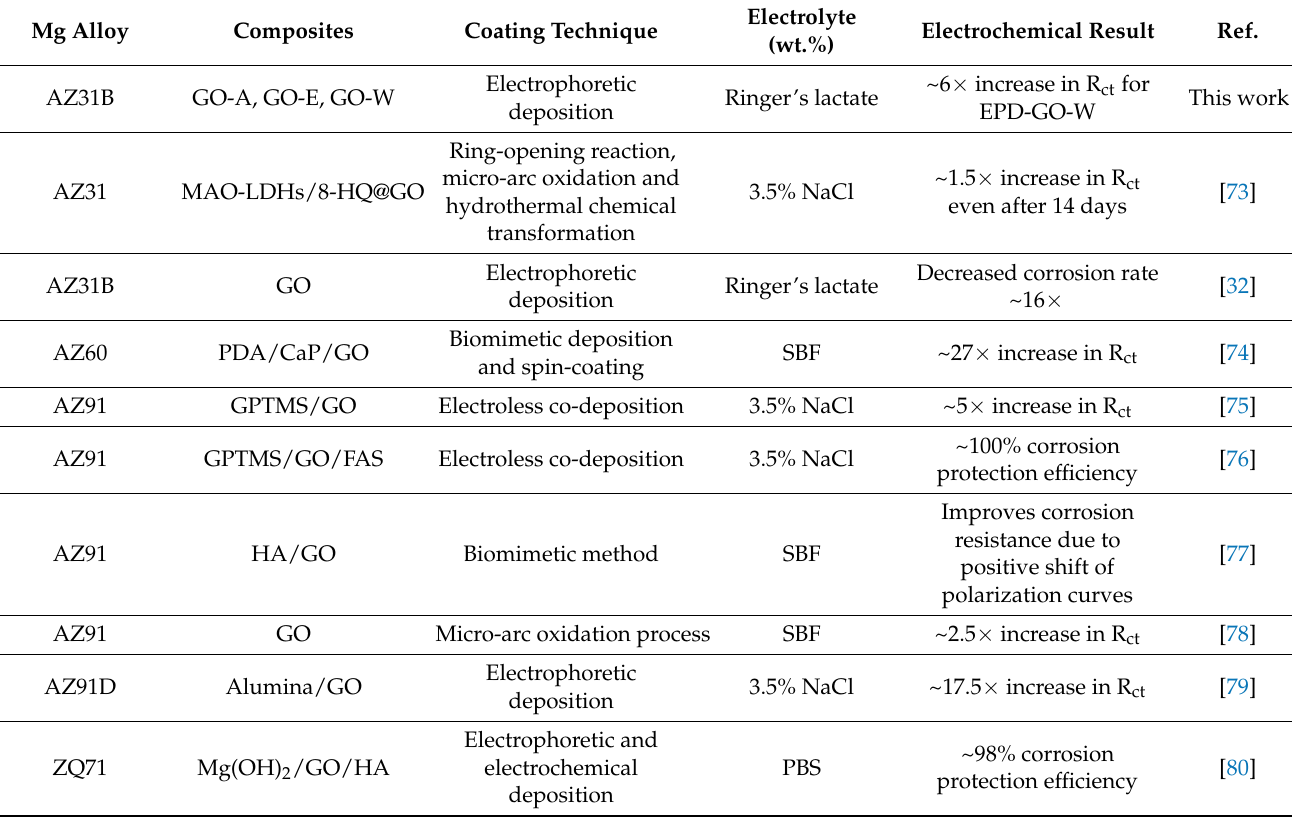
Table 3. Different composite coatings and results from the current study and already conducted